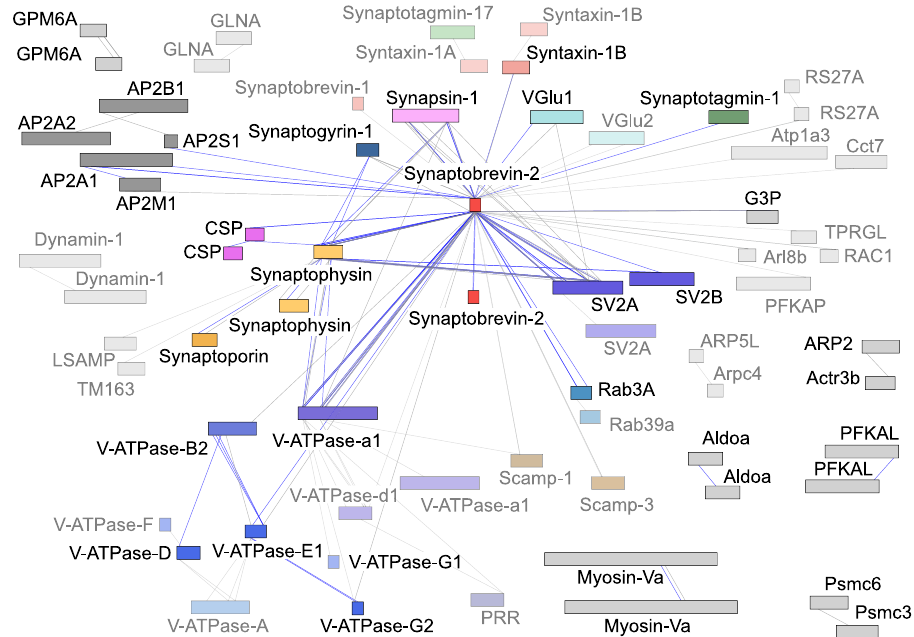
Fig. 3 Protein interaction network of unstimulated, untreated synaptic vesicles. Synaptic vesicle proteins are shown as coloured bars; contaminants are shown as grey bars. The length of the bars corresponds to the protein length. The N-terminus is on the left and the C-terminus is on the right side of the bar. Inter-molecular cross-links identi fi ed in one (grey) or at least two (blue) biological replicates are shown. Proteins that are linked through interactions from only one biological replicate are